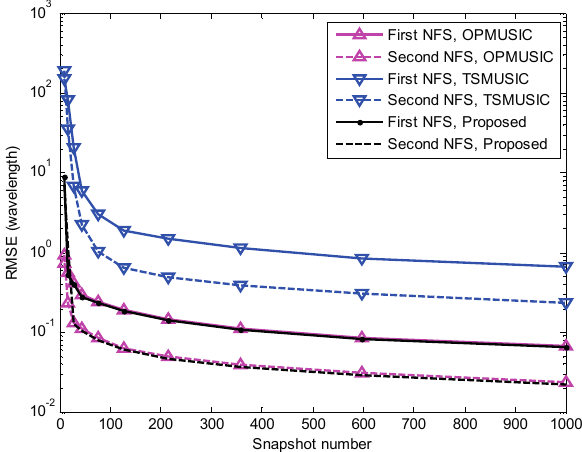
Figure 9. RMSEs of FFSs DOA estimates versus snapshot number. 500 independent trials are realized for each of the three methods.